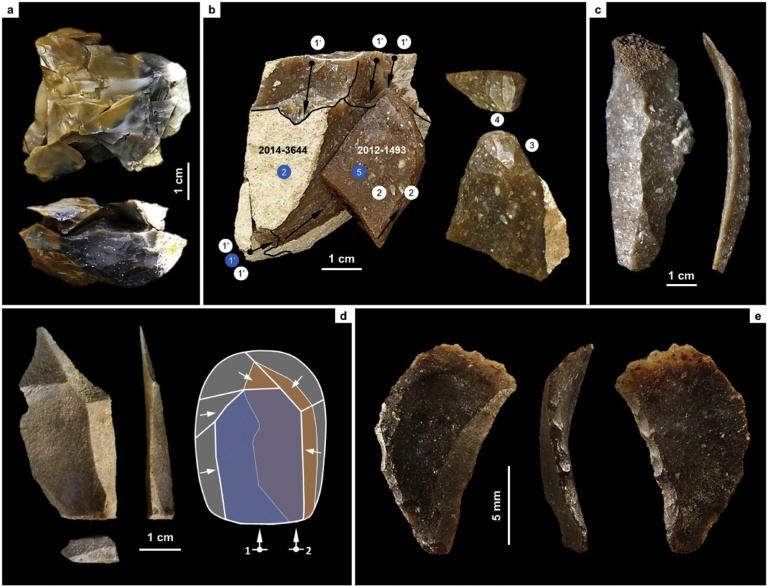
Blank production and diagnostic stone tools across the Middle-to-Upper Paleolithic transition in the the Mula basin sites. a. Centripetal core for small flakes, with refits (Cueva Antón, layer I-k, Mousterian). b. Multi-step reduction sequence for the production of bladelets (La Boja, OH20, Aurignacian): preparation (1) or re-preparation (1′) of a prismatic core for the extraction of long, thick blades (2), followed by preparation of such laminar blanks as carinated or nosed “scrapers” (3), extraction of bladelets from the “scraper front” (4), and eventual discard of the exhausted “scraper”/core (5); the blue circles denote steps represented in the refit, the white circles denote steps represented by removal scars or among the block’s unrefitted material. c. long blade with minor, proximal break (La Boja, OH20, Aurignacian). d. Laminar Levallois flake, representing a lateral removal after the extraction of a preferential flake in a Levallois recurrent reduction sequence (Cueva Antón, layer I-k, Mousterian). e. Characteristically twisted Dufour bladelet of the Roc-de-Combe subtype extracted from a carinated or nosed “scraper”/core (La Boja, OH17, Aurignacian).